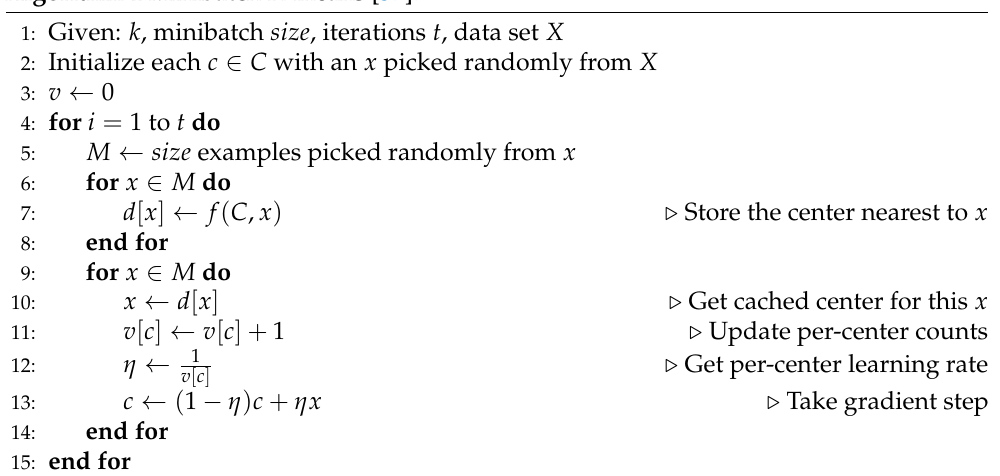
Algorithm 1 Minibatch K-means